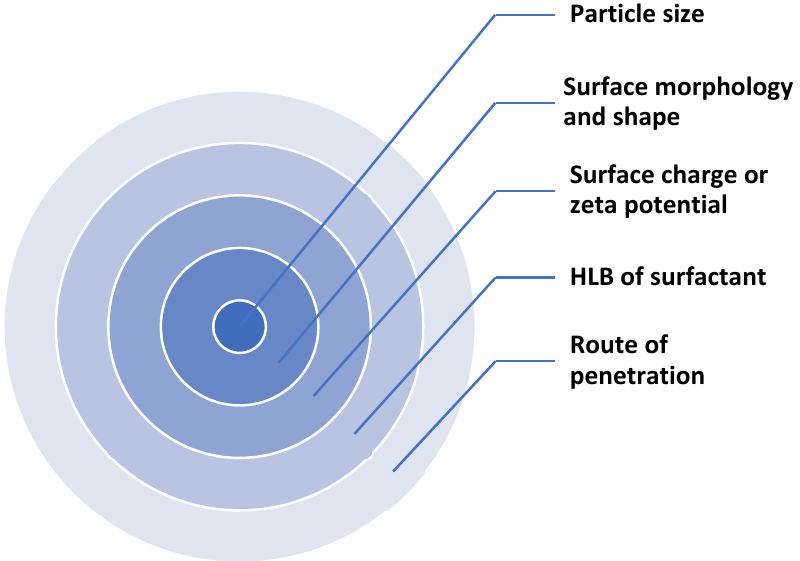
Figure 3. Major factors affecting percutaneous permeation and release kinetics of lipid nanoparticles loaded with active ingredients/bioactive. HLB = hydrophilic-lipophilic balance.